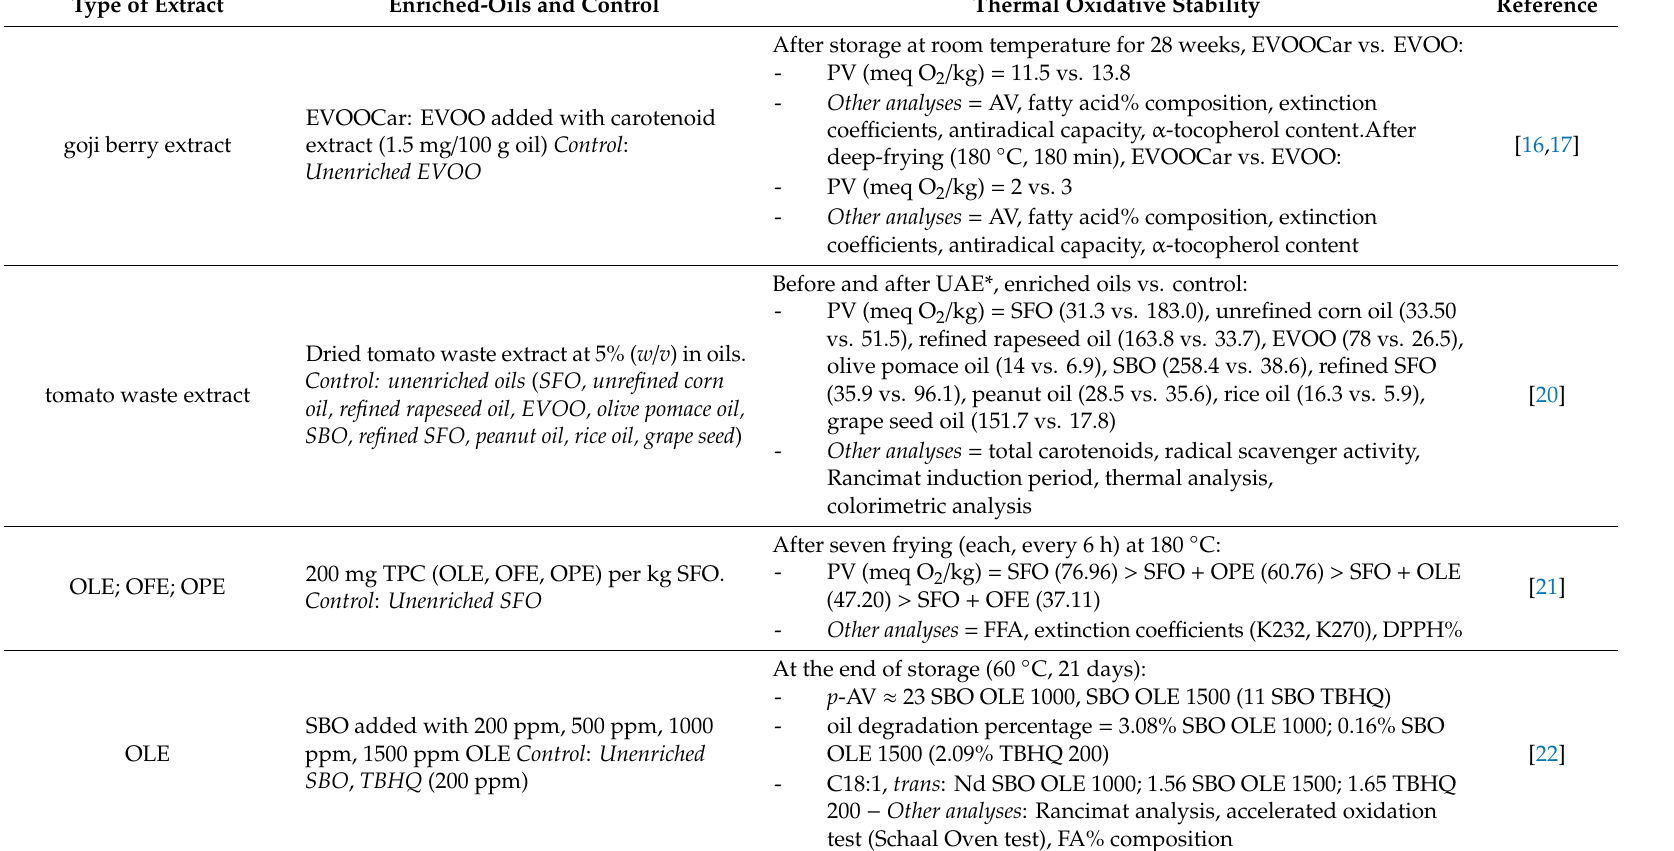
Table 3. Natural antioxidants added to oils: Type of extract, oil enrichment and thermal oxidative stability. Type of